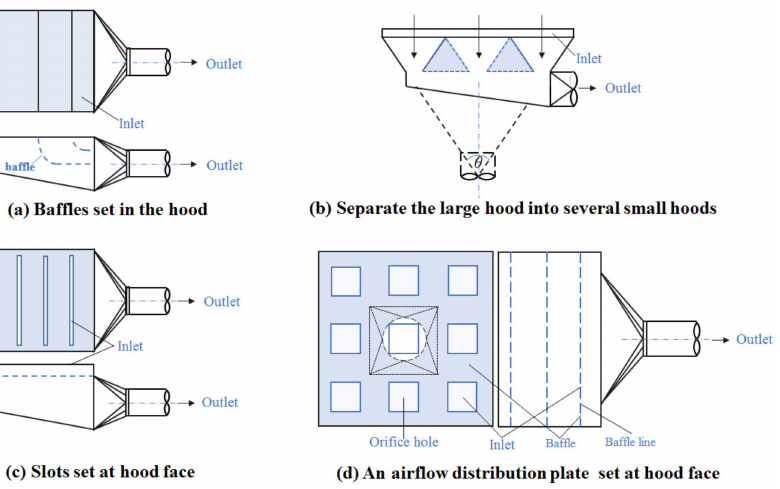
Figure 2. The methods for achieving a uniform airflow distribution at the hood face. θ is the inclination.